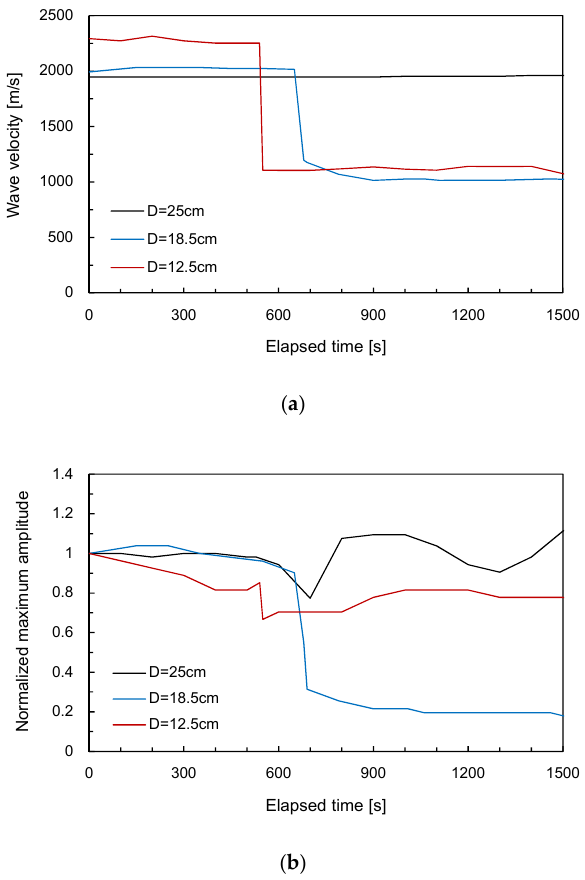
Figure 9. Variation in wave velocities and the maximum amplitudes along the elapsed time for the rock specimen: ( a ) wave velocity; ( b ) maximum amplitude.